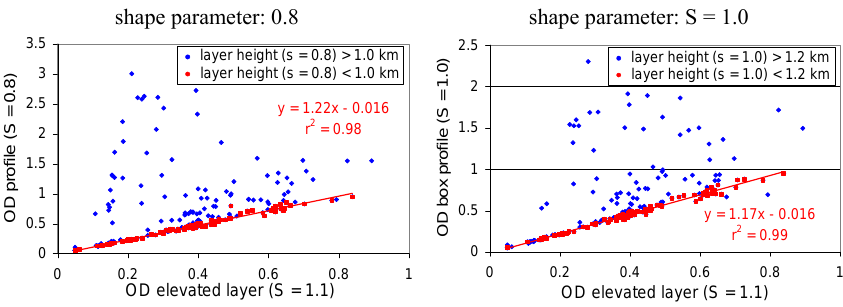
Fig. 4. Comparison of MAX-DOAS AODs retrieved for different shape parameters S for clear days. The AOD for S = 0.8 (left) and S = 1.0 (right) is plotted versus the AOD retrieved for S = 1.1. Good agreement is found for retrieved layer heights below 1.2 km (S = 0.8) and 1.2 km (S = 1.0), respectively.